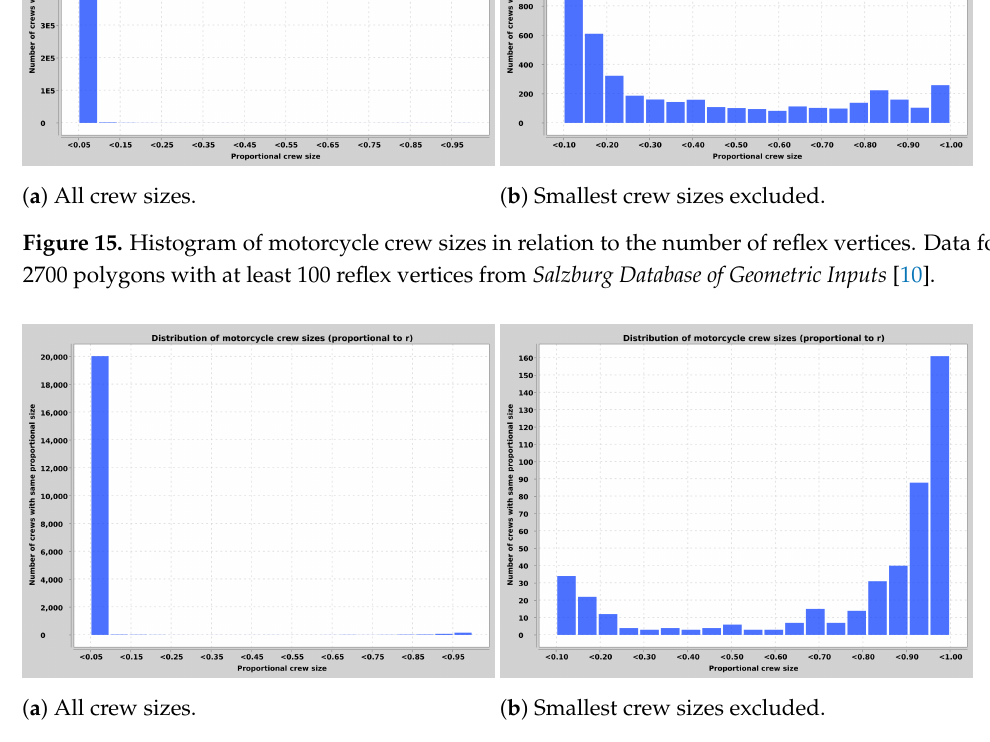
Figure 16. Histogram of motorcycle crew sizes in relation to the number of reflex vertices. Data for 380 country outline based polygons with at least 100 reflex vertices from Natural Earth [11] and DIVA-GIS